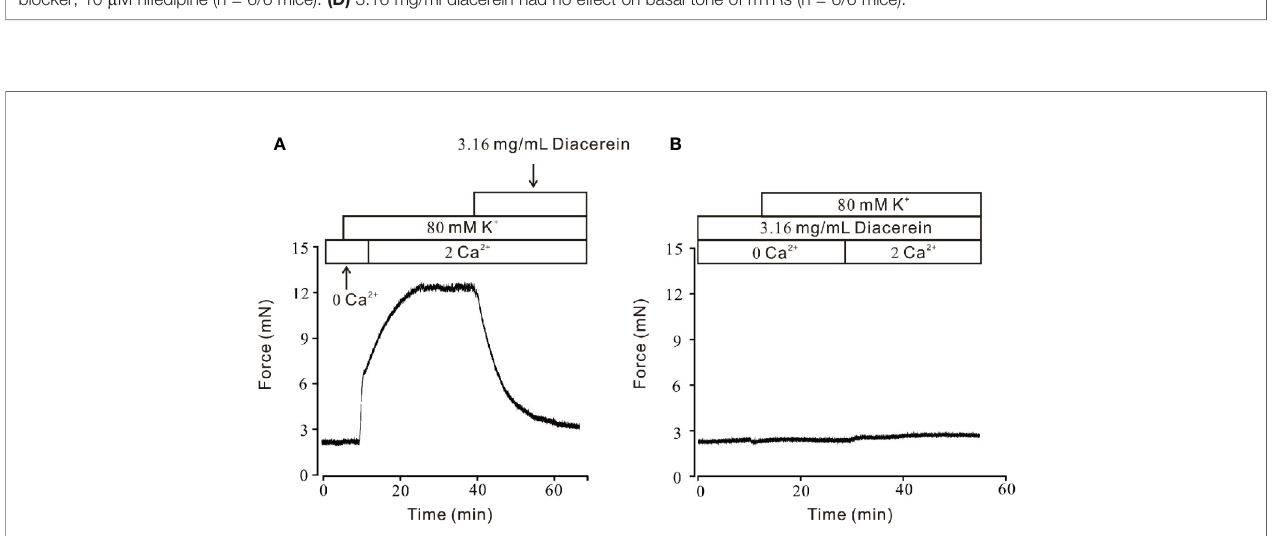
FIGURE 2 | Diacerein blocked high K + -induced Ca 2+ in fl ux. (A) High K + evoked a sustained contraction when the calcium concentration in solution switched from 0 to 2 mM. Subsequently, the contractile effect was almost completely erased by 3.16 mg/ml diacerein (n = 6/6 mice). (B) In the presence of 3.16 mg/ml diacerein, high K + failed to induce contraction on mouse tracheal rings (TRs) either under Ca 2+ -free condition or after 2 mM Ca 2+ restoration (n = 6/6